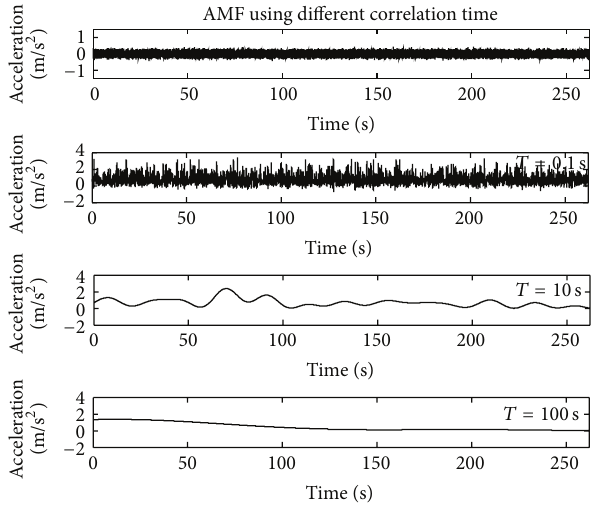
Figure 11: Time history of field data and synthesized AMF.